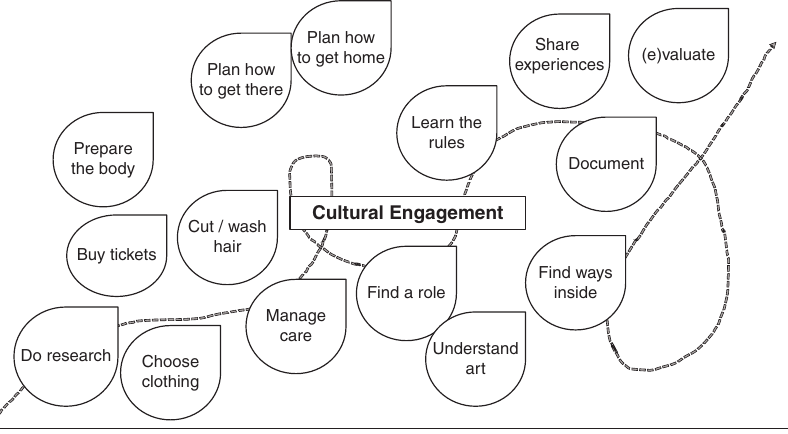
Figure 1. Practices of going to the